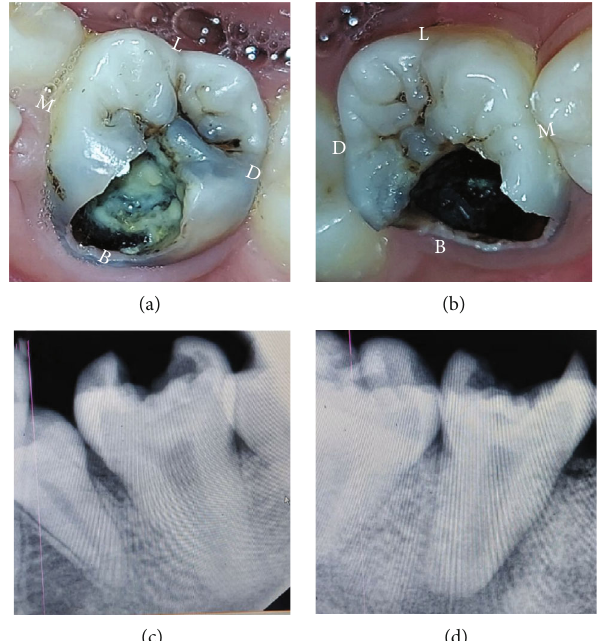
Figure 1: (a, b) Preoperative view of #36 and #46. (c, d) Preoperative IOPA of #36 and #46. B: buccal; L: lingual; D: distal; M: mesial.